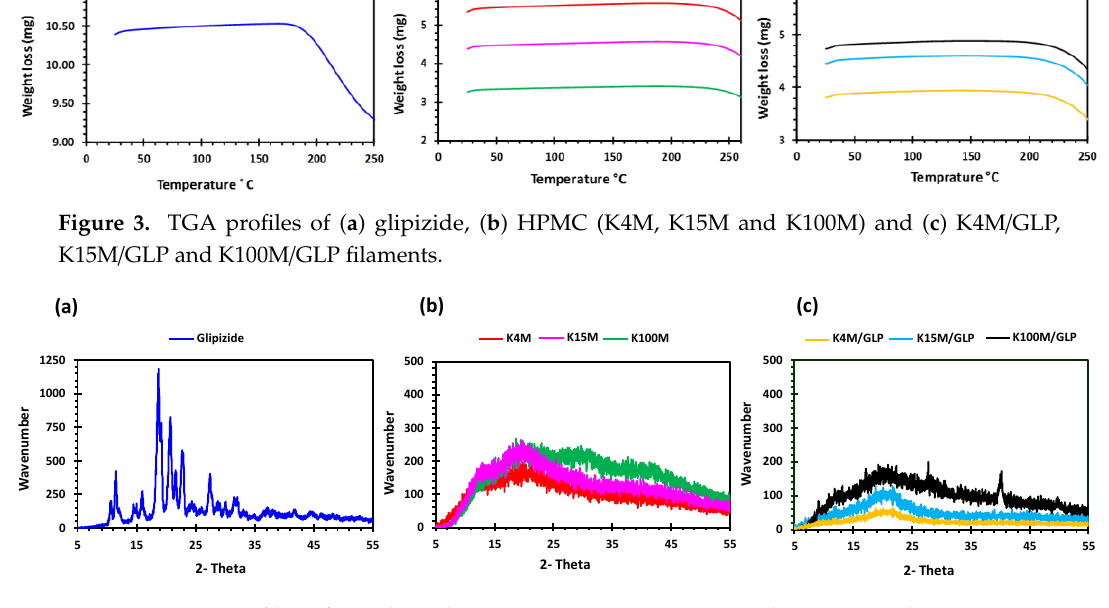
Figure 4. XRD profiles of ( a ) glipizide, ( b ) HPMC (K4M, K15M and K100M) and ( c ) K4M/GLP, K15M/GLP and K100M/GLP filaments.